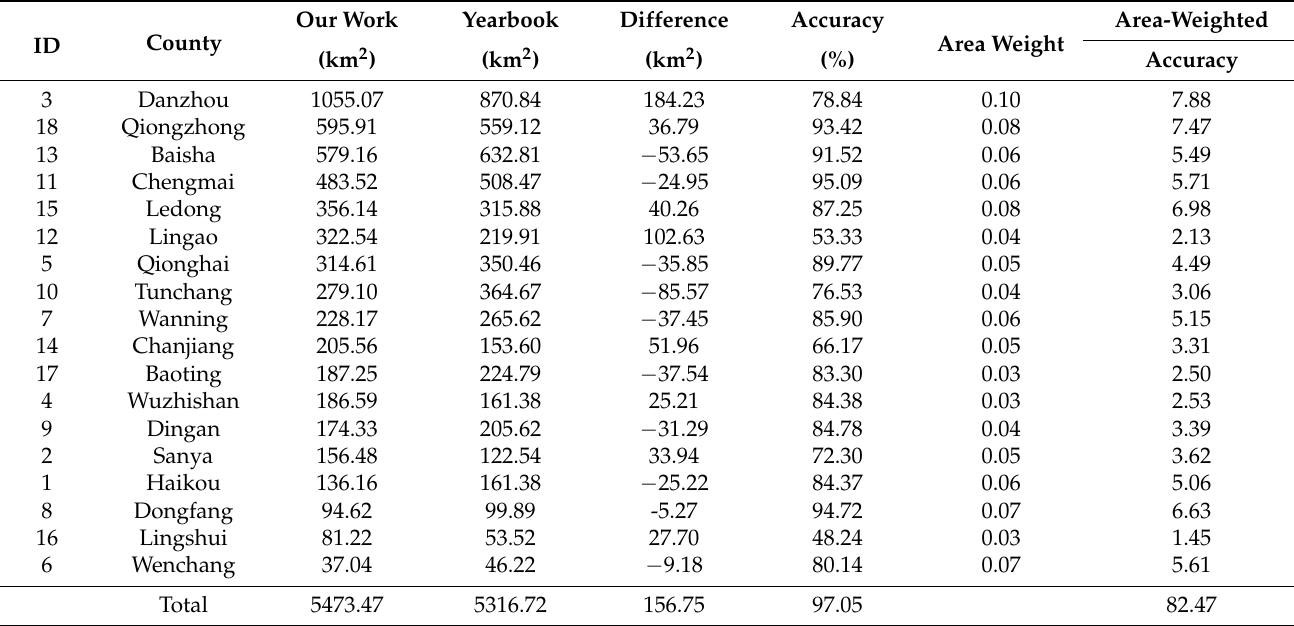
Table 4. Accuracy assessment at the county level using statistical data.